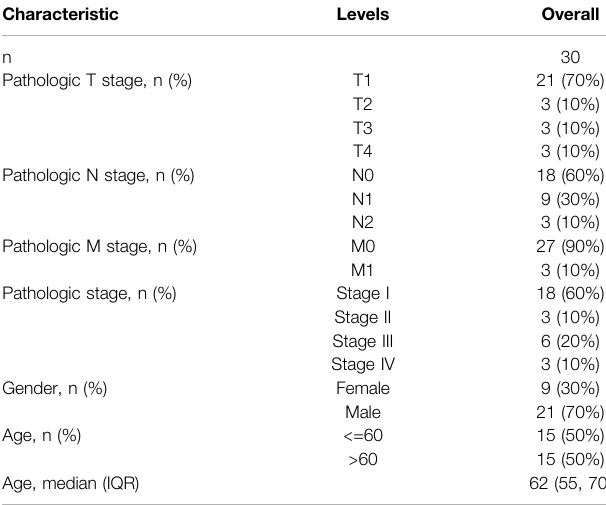
TABLE 3 | Basic clinical characteristics of KIRP patients in validation